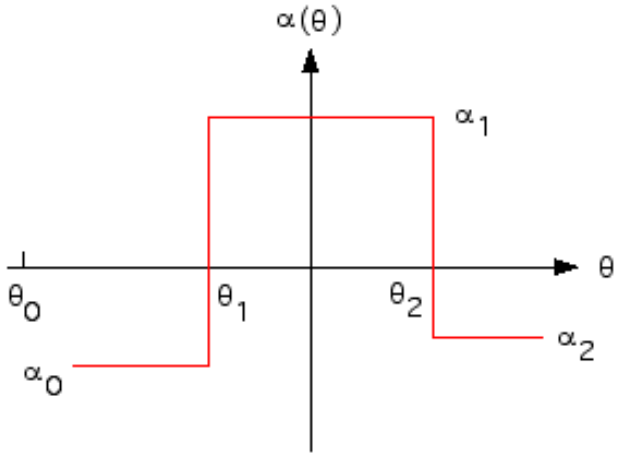
FIG. 1. (Color) Two crossings of a resonance by sudden jumps of spin